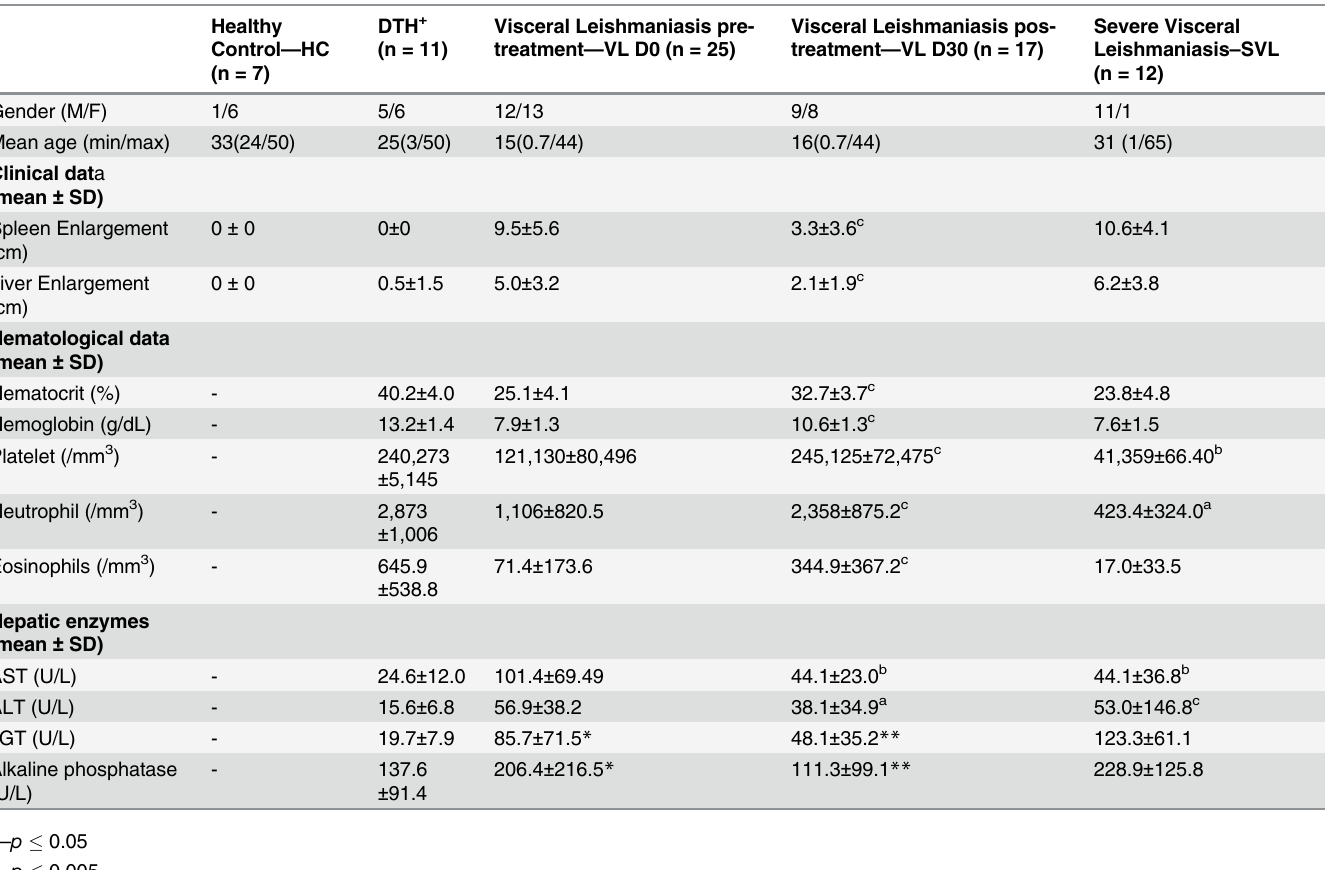
Table 1. Demographic and clinical characteristics of the studied